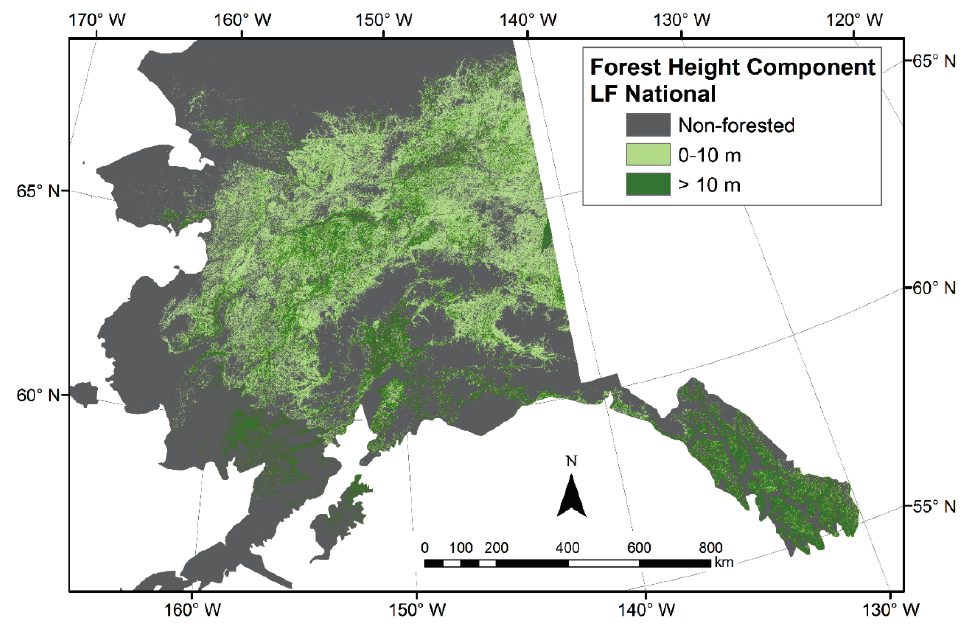
Figure 1. Original map of LANDFIRE National forest height component for Alaska mapped as two classes.